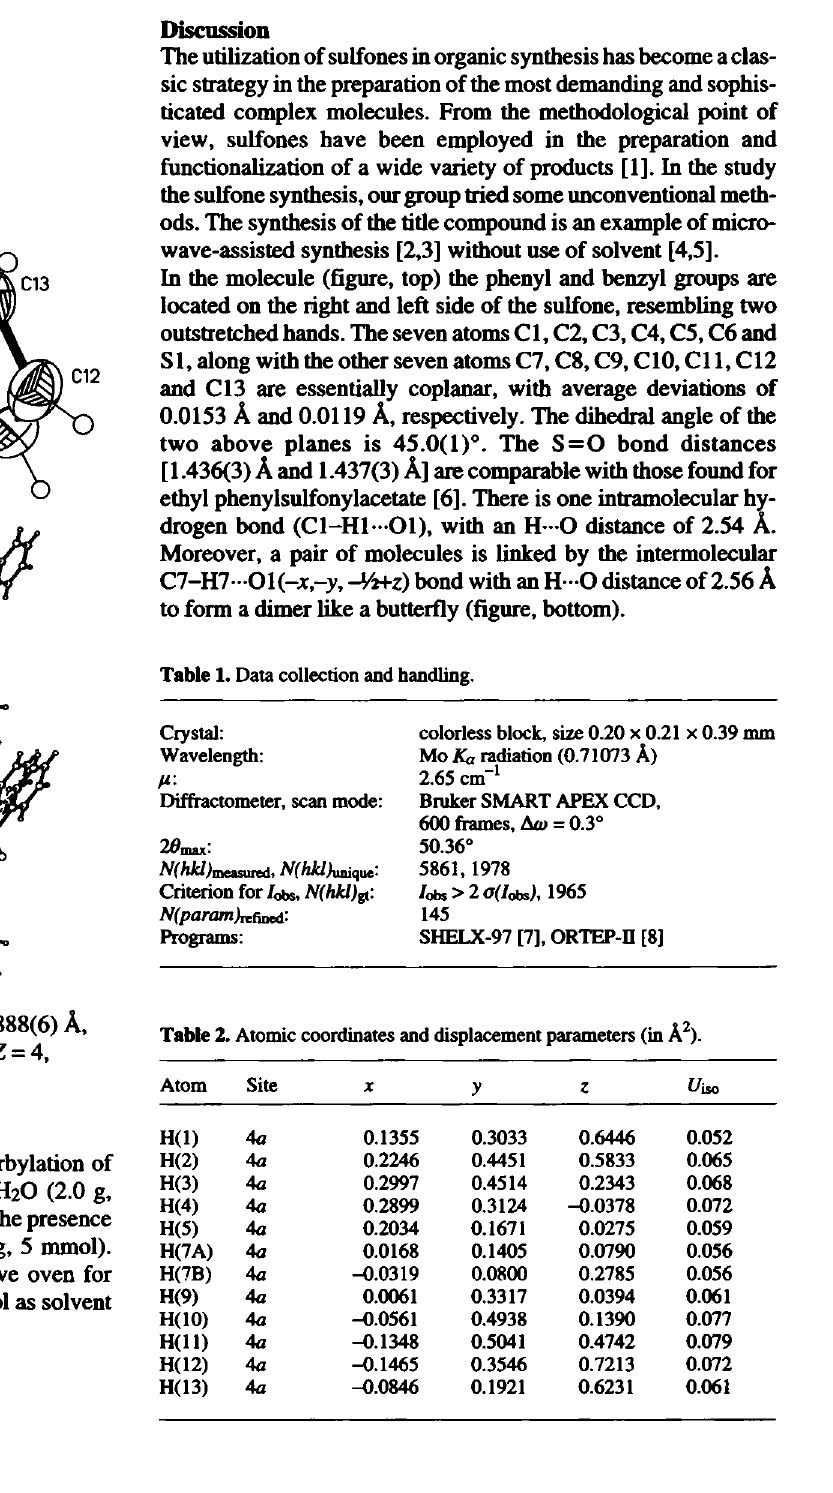
Table 2. Atomic coordinates and displacement parameters (in Ä 2